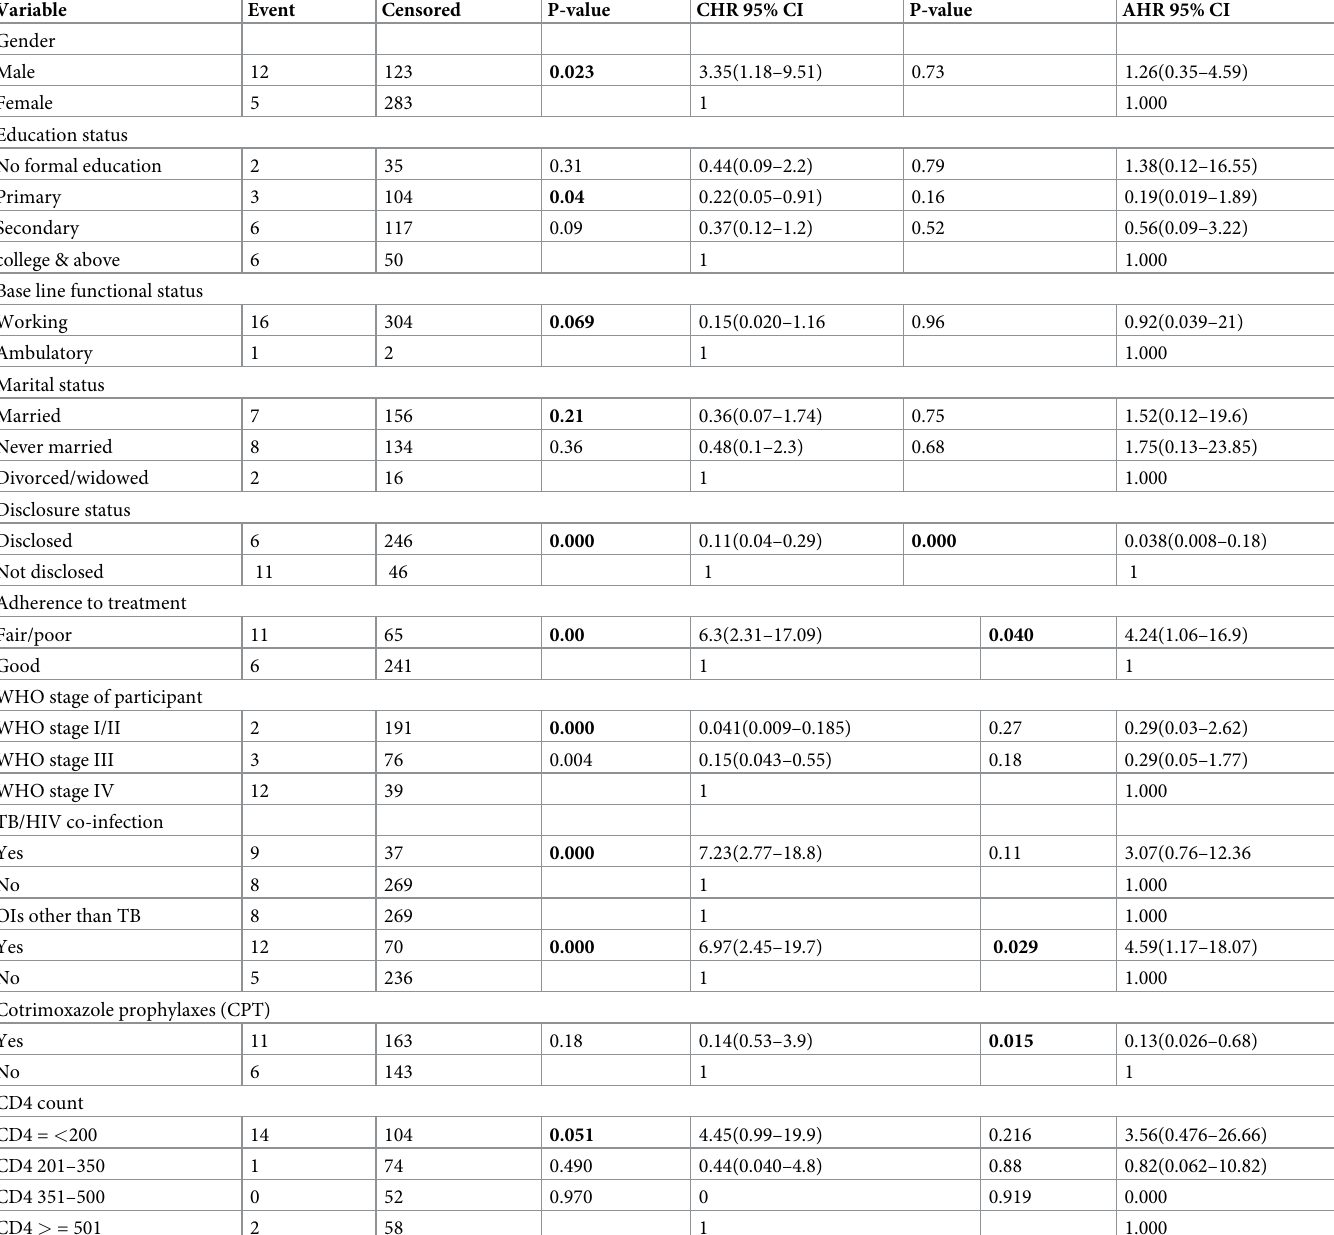
Table 3. Factors associated with virological failure among first ART clients in St. Paul’s Hospital Millennium Medical College, Addis Ababa, Ethiopia from July 2016 to December